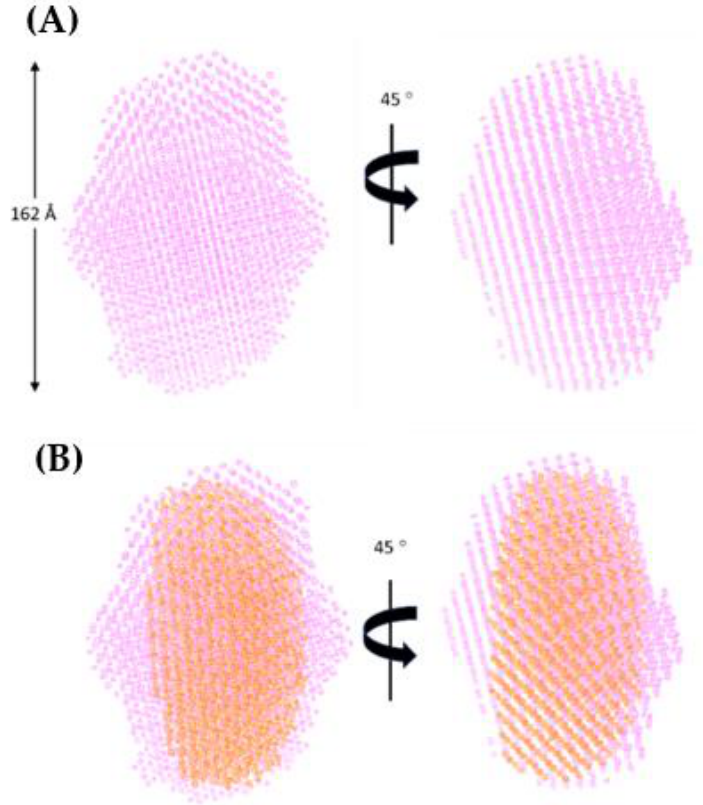
Figure 6. Envelope models of the A3G fl tetramer with and without CCdZ-T30-oligo. ( A ) Envelope model of the A3G fl tetramer/CCdZ-T30-oligo (purple) generated under P2 symmetry (DAMMIF, ATSAS 2.8.3 suite), with D max ~ 162 Å and R g ~ 47 Å. ( B ) A3G fl tetramer/CCdZ-T30-oligo envelope model superimposed with ligand-free A3G fl tetramer envelope model (orange).